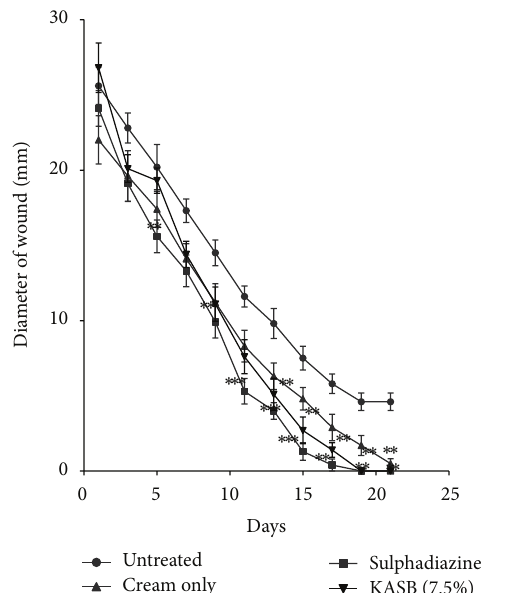
Figure 7: Influence of methanol stem bark extract (KASB) cream (7.5% w/w) of K. africana on the rate of closure of wounds. Values are diameter of wounds expressed as mean ± SEM ( 𝑁 = 5 ). ∗ 𝑃 < 0.05 , ∗∗ 𝑃 < 0.01 , and ∗∗∗ 𝑃 < 0.001 . Control is the untreated wounds. 1% w/w silver sulphadiazine was used as positive control.